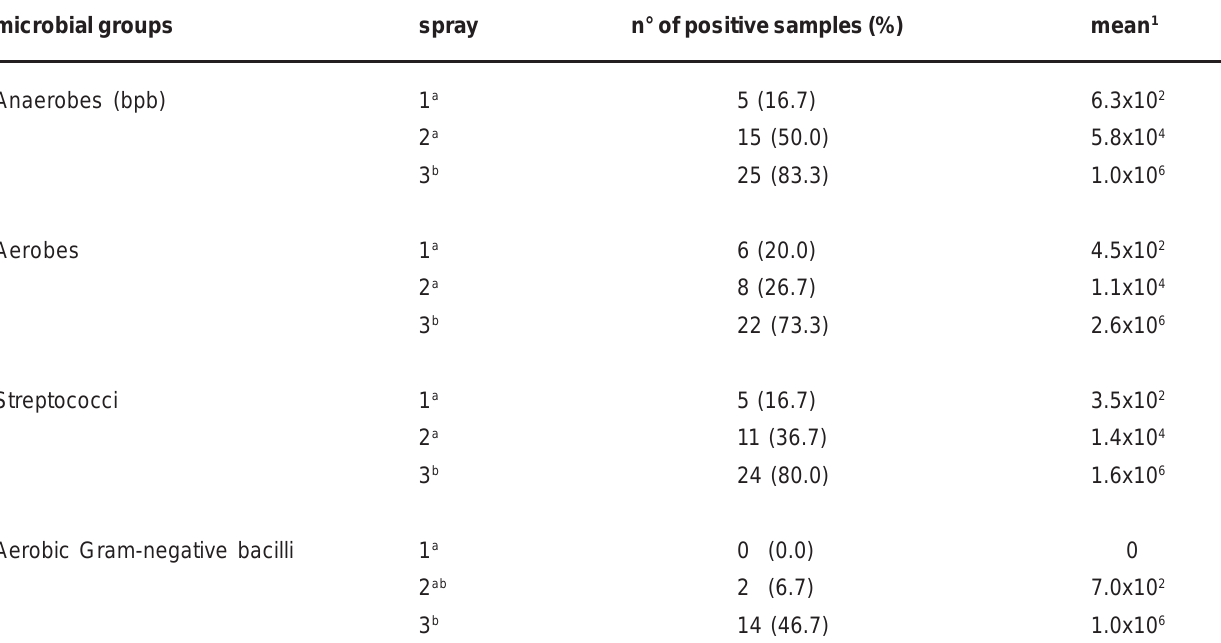
TABLE 2- Frequency of positive samples and mean of microorganisms isolated from the